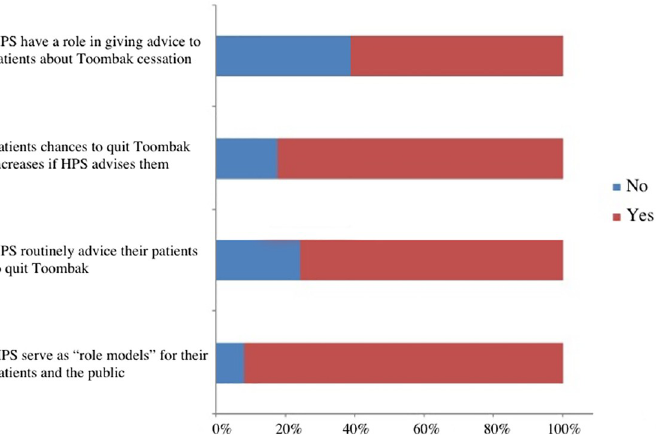
Fig 1. Frequency and percentages % (n) of students’ perceived status as a role model in Toombak cessation by health professions